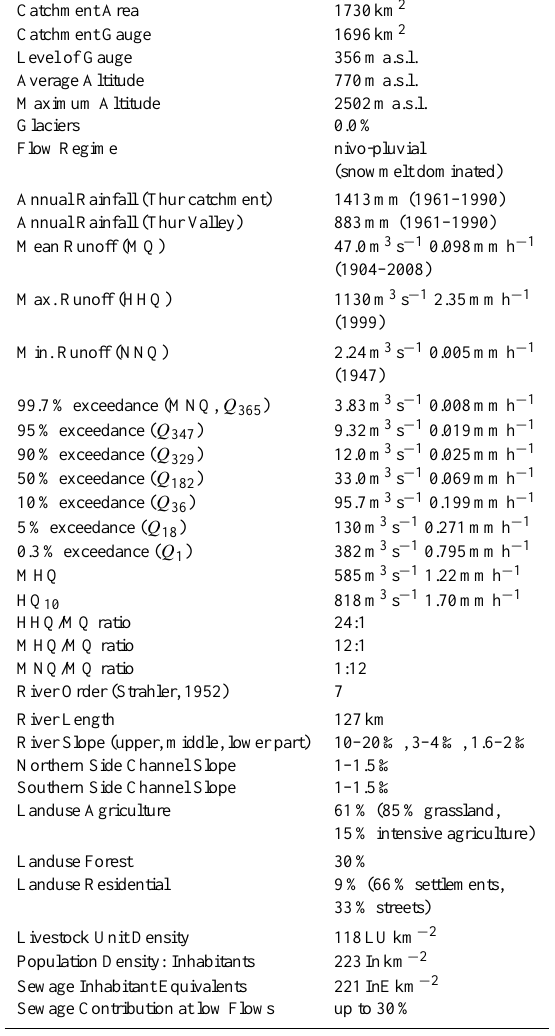
Table 1. Key descriptors of the Thur River (BAFU, 2010). Table 2. Key descriptors of the Thur Valley aquifer (Baumann et al.,